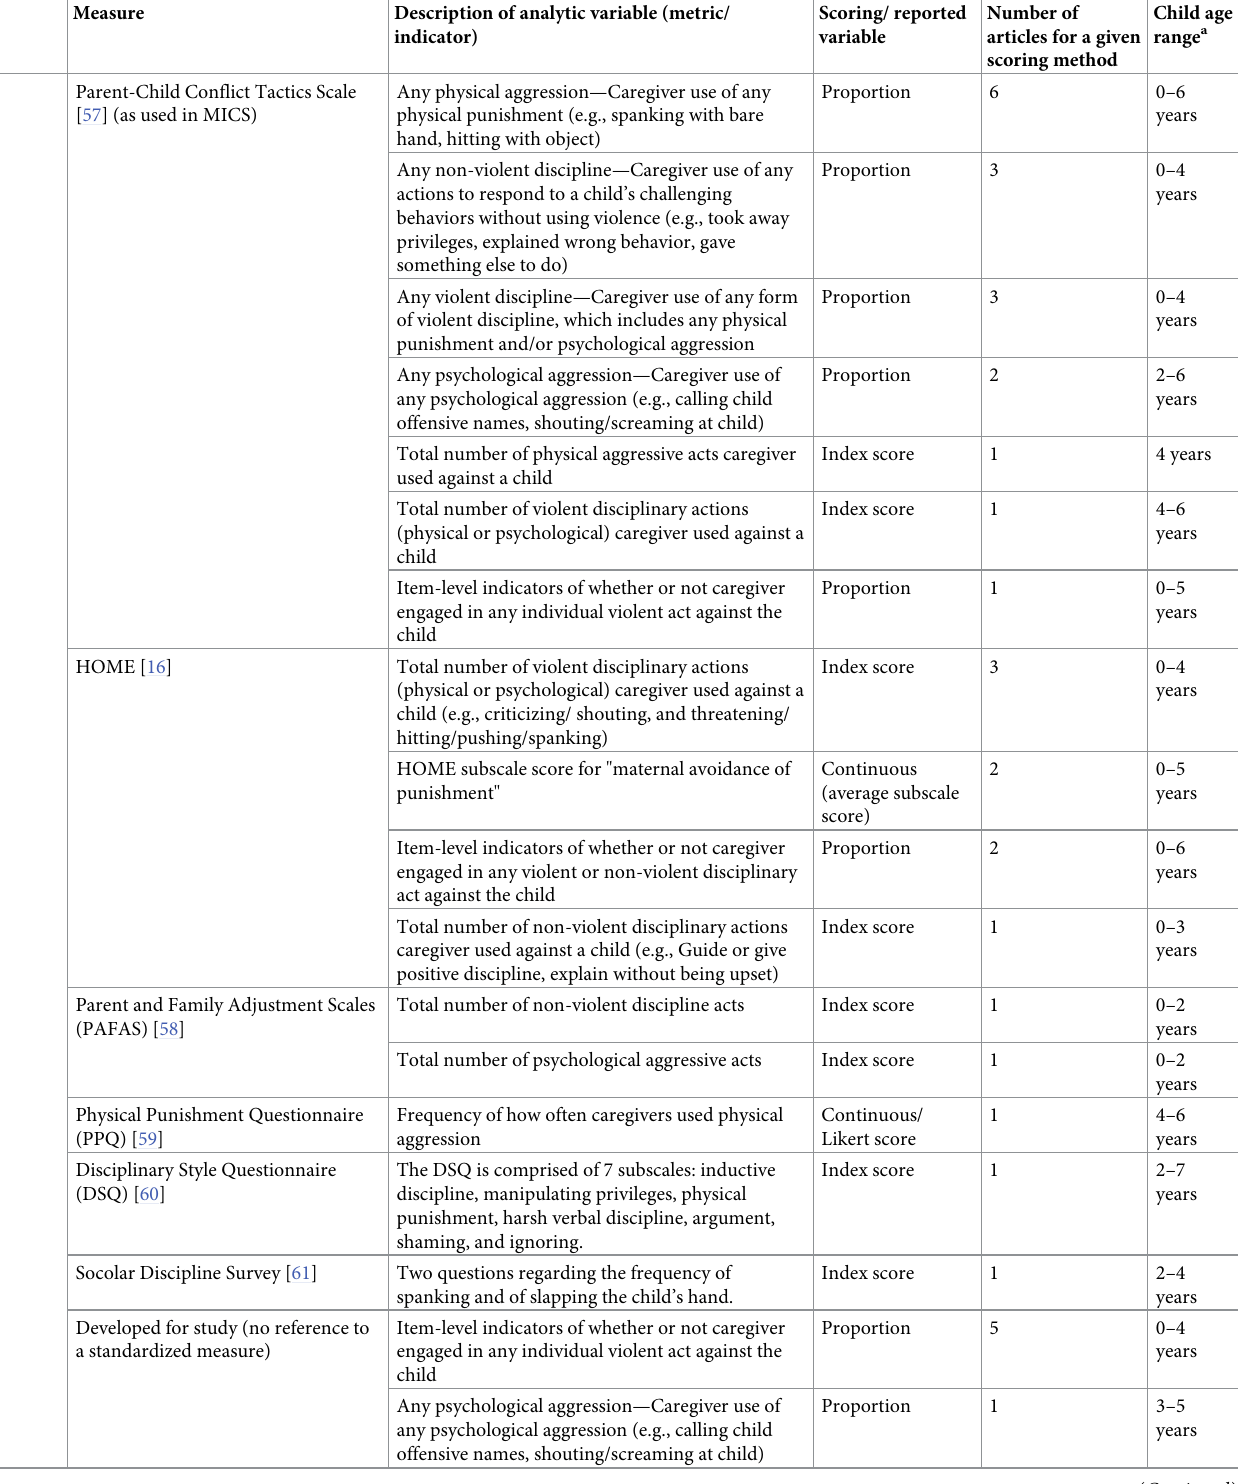
Table 5. Safety and